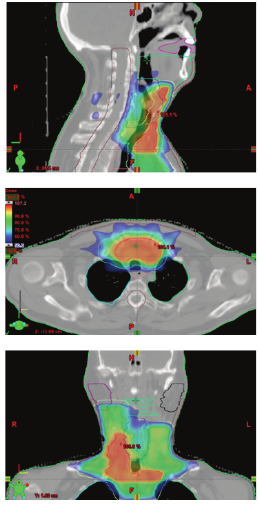
Figure 1: Radiation dose distribution for a 65-year-old male with ATC, status post gross total resection with involved cervical nodes. 51 Gy delivered in 17